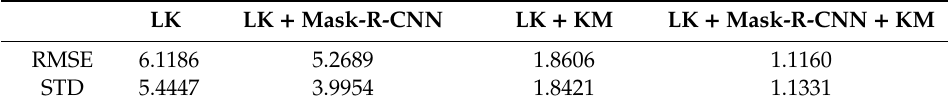
Table 7. Velocity errors of four algorithms in the X direction.